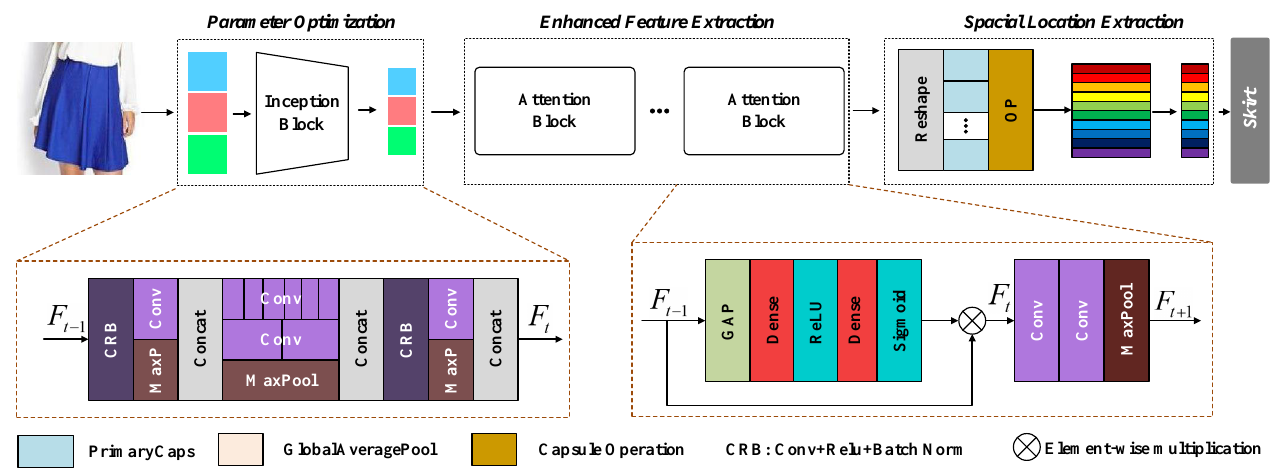
Figure 1. Overview of the proposed EnCaps. The network architecture consists of three main parts: (1) Parameter Optimization; (2) spatial structure Extraction; and (3) spatial structure